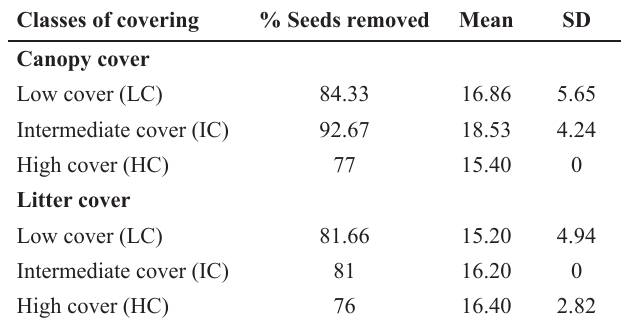
Table 1 . Variation in the removal of diaspores by ants by classes of canopy and litter cover: 0 to 33% (LC), 34 to 66% (IC) and 67 to 100% (HC) in Cerrado Stricto Sensu areas.